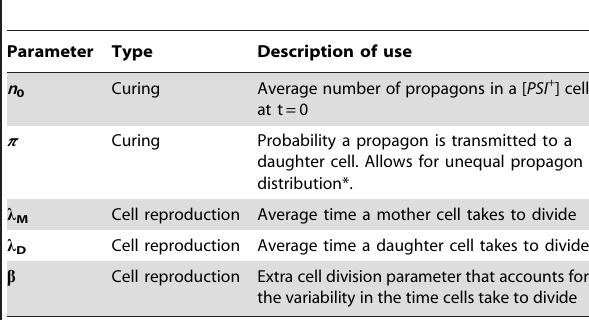
Table 1. The parameters used in curing model C and their